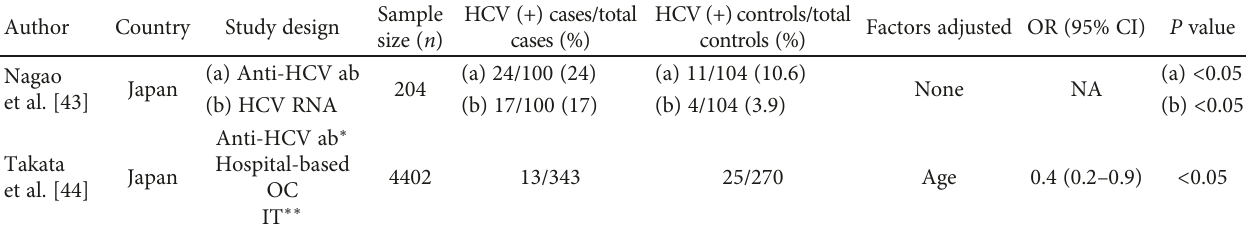
Table 7: Case-control studies for association of chronic HCV infection with oral cancer